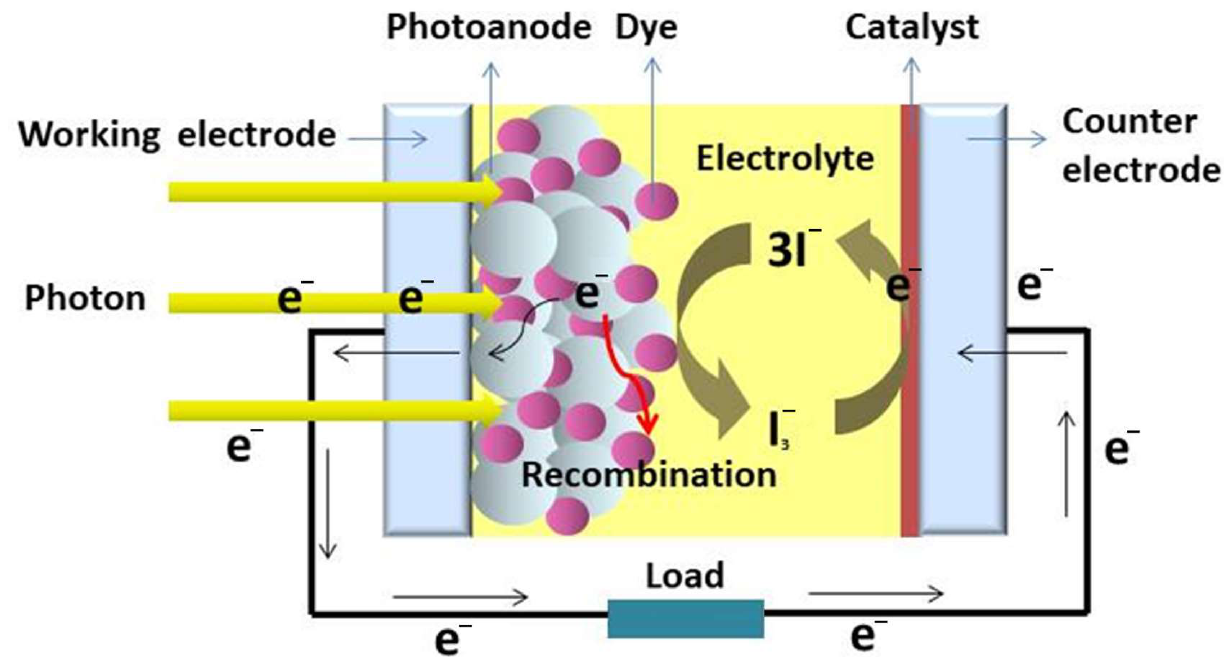
Figure 1. An electrical and chemical reaction in a DSSC structure during photon absorption. A dye molecule ( S ) is struck by photon energy ( hv ), which causes it to enter the excited state ( S* ). When an electron escapes from a dye molecule and enters a photoanode nanostructure, the molecule develops a hole ( S + ).